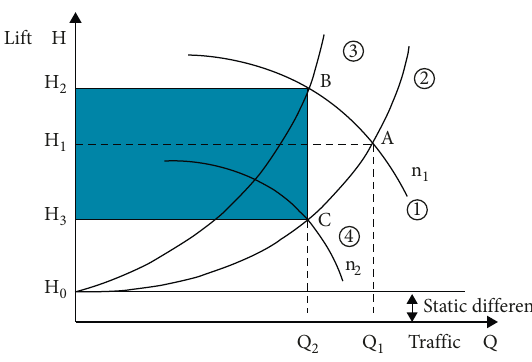
Figure 5: H ∼ Q curve of speed regulating operation of the water